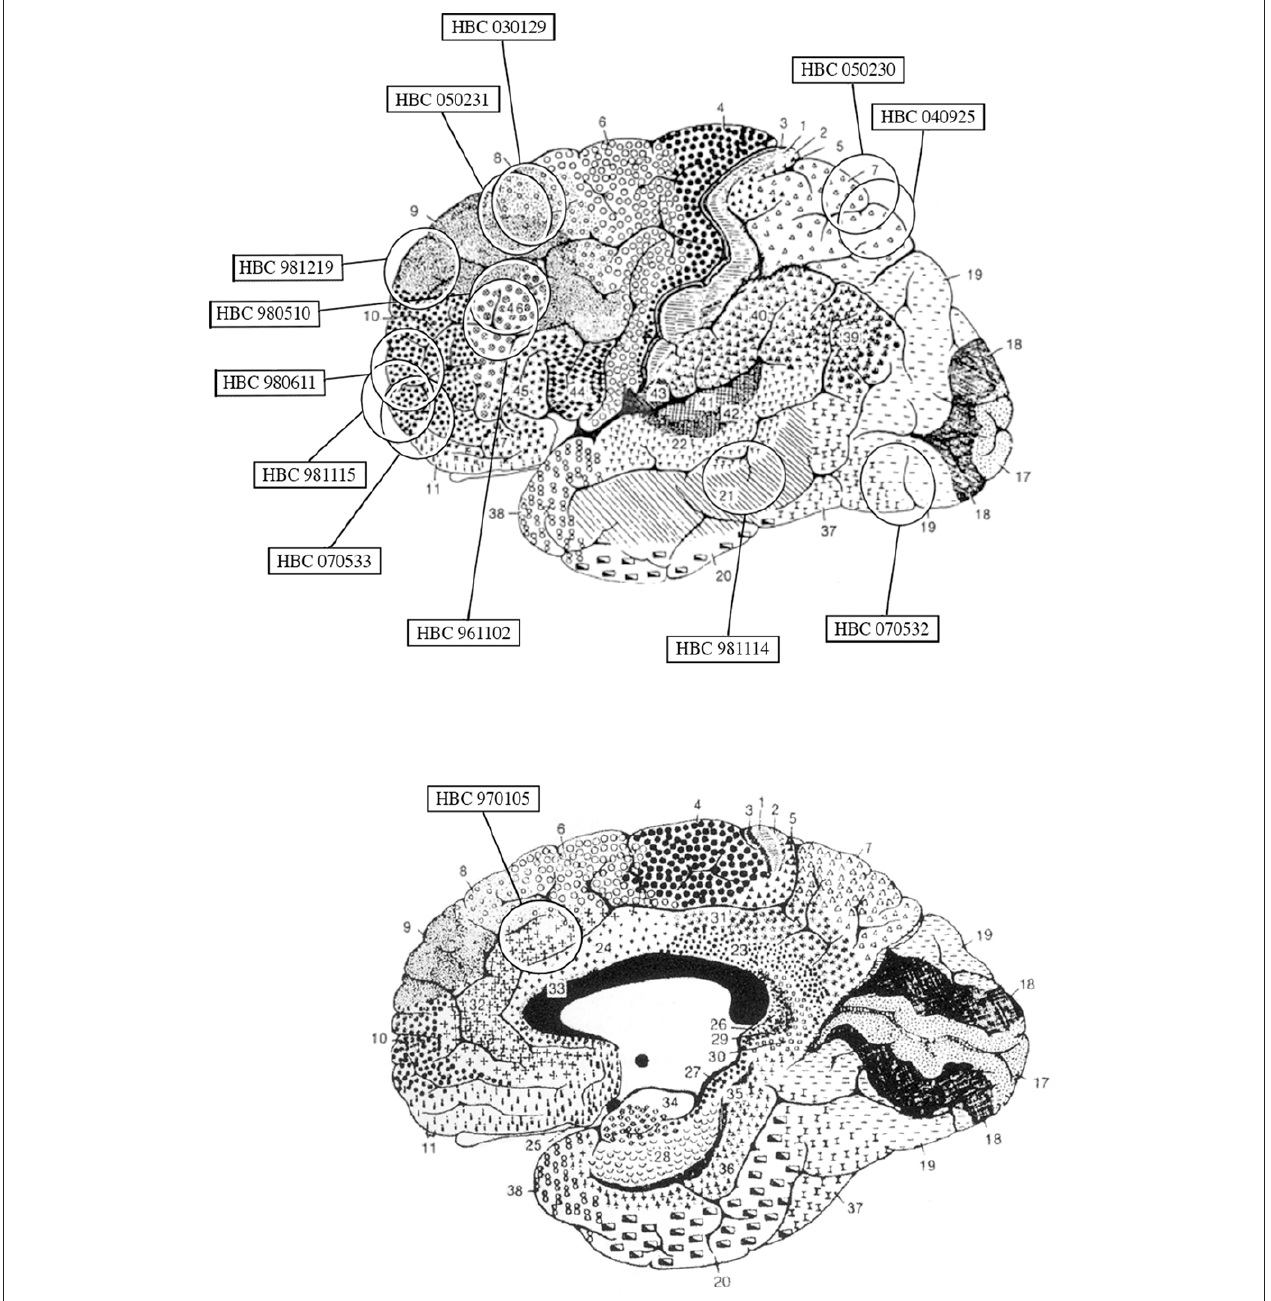
FiGurE 1 | Diagram based on the surgeon’s estimate of cortical resections and on magnetic resonance imaging findings showing the approximate location of the cortical samples used in the present study superimposed on Brodmann’s cytoarchitectonic map of the human cerebral cortex. Modified from Brodmann